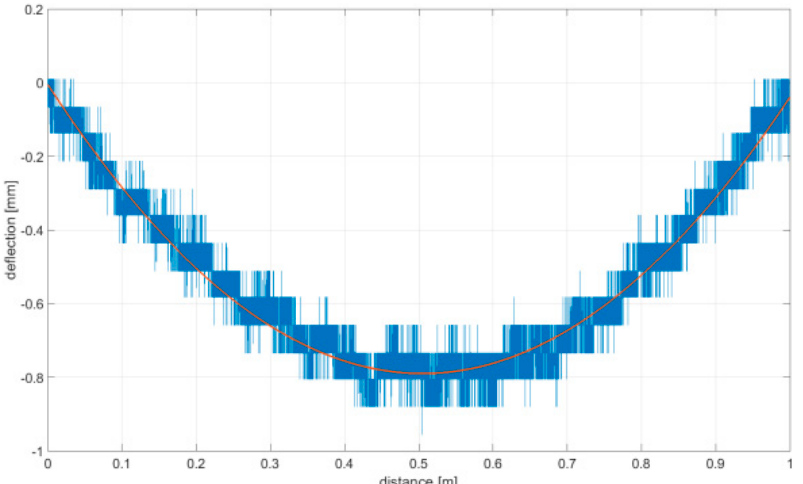
Figure 9. Deflection measurements (aluminum beam) are given in blue color; measured path interpolated with a polynomial function of 2 degrees is shown in red color.